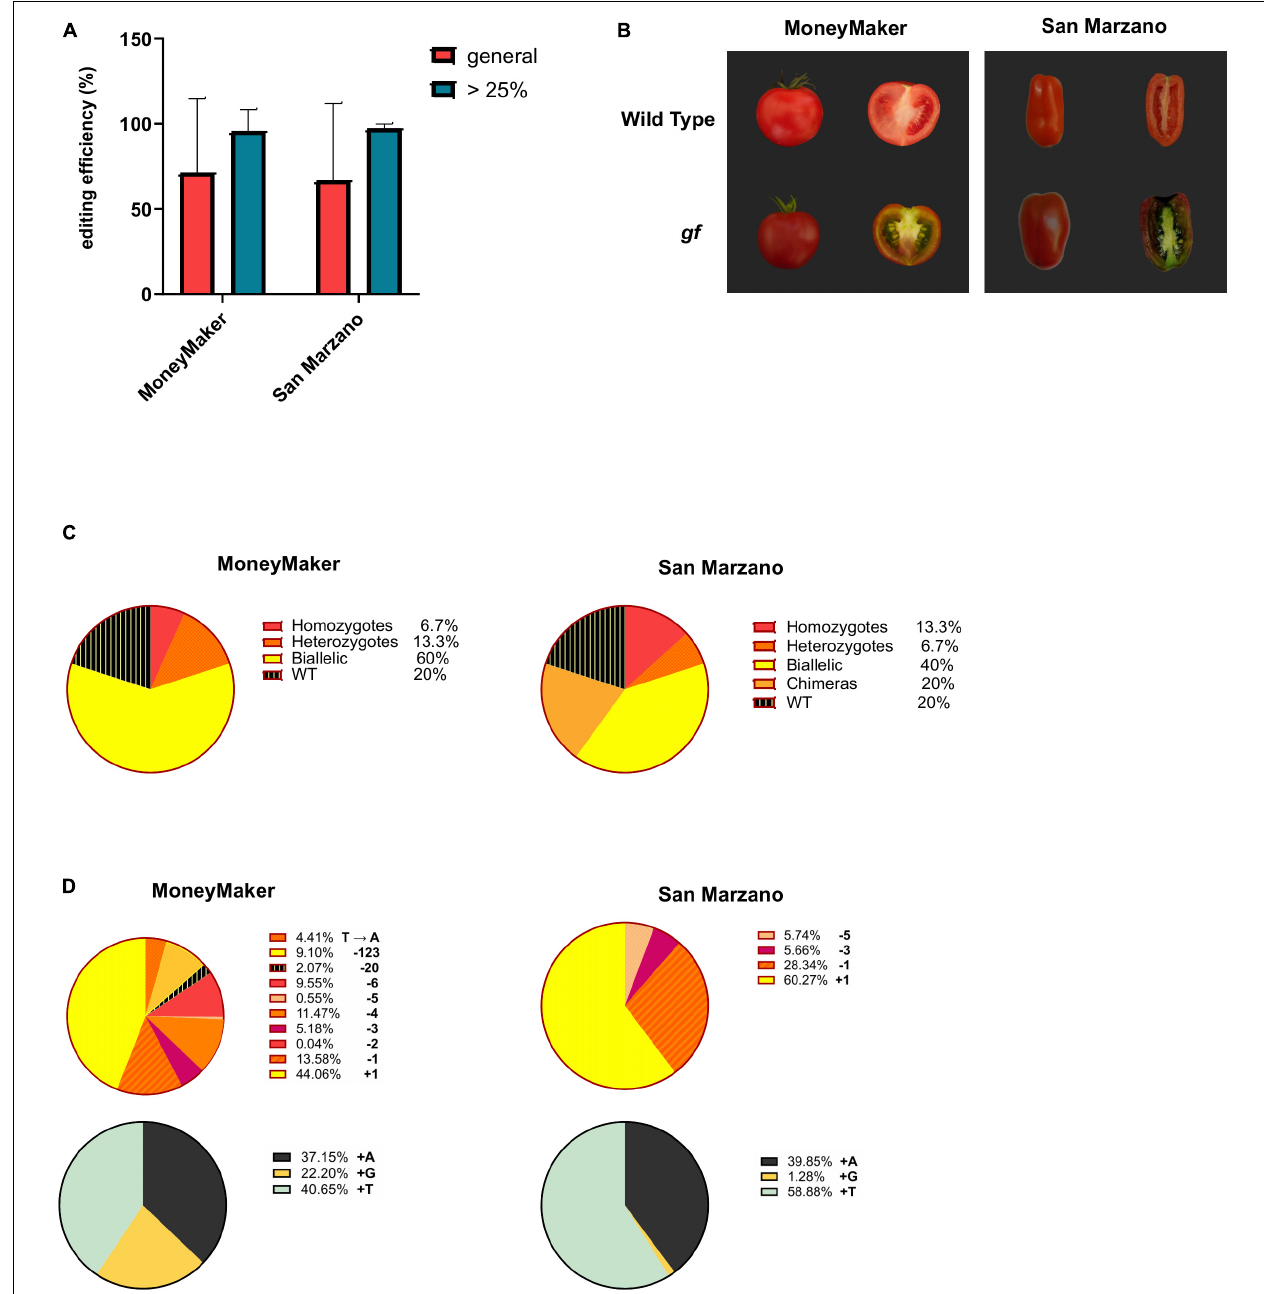
FIGURE 2 | Evaluation of editing events. (A) Editing efficiency for the ‘MoneyMaker’ and ‘San Marzano’ tomato varieties. Editing efficiency for each cultivar is expressed as the means of the editing efficiencies for each plant, these being calculated as the % of mutated reads for each individual. Red bars indicate the editing efficiency for the general ‘MoneyMaker’ or ‘San Marzano’ population (15 plants each), while blue bars represent the editing efficiency in the sub-population of plants with editing levels above 25%. Error bars indicate standard deviations. Editing efficiencies between cultivars are not significantly different (Student’s t -test, p = 0.77 for the general population, p = 0.7 for the sub-population with editing above 25%). (B) gf phenotype in ripe fruits of the ‘MoneyMaker’ and ‘San Marzano’ cultivars. Ripe fruits of the two cultivars share a similar phenotype, with darkened pericarp and mesocarp due to the simultaneous presence of chlorophylls and carotenoids, and green placenta. (C) Allelic configuration of the ‘MoneyMaker’ and ‘San Marzano’ gf populations. Pie charts represent the frequency of each allelic configuration in the two cultivars (WT, chimeric, heterozygous, biallelic, or homozygous). (D) Allelic frequencies in the ‘MoneyMaker’ and ‘San Marzano’ gf populations. The upper pie charts represent the frequency of each detected allele in ‘MoneyMaker’ and ‘San Marzano’ edited T 0 plants, while the lower pie charts detail the frequency and identity of single nucleotide insertions, the most common mutations found in both cultivars.